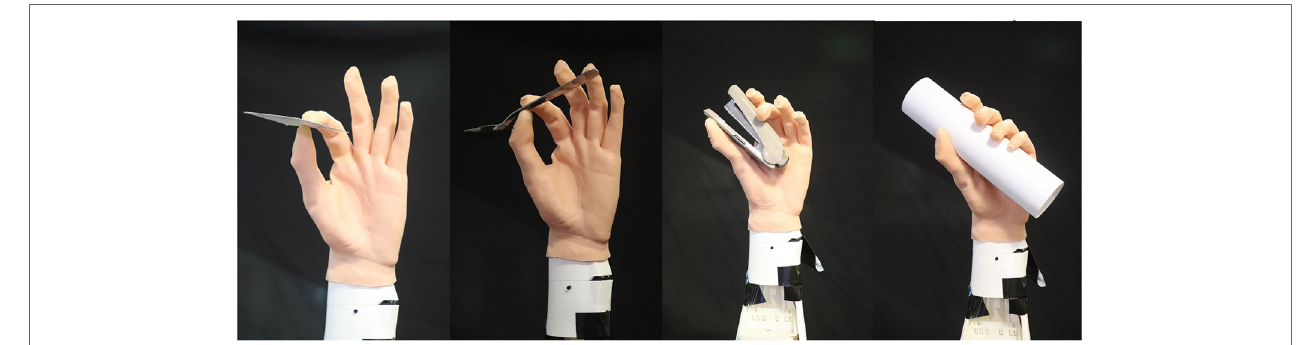
FigUre 10 | Grasping experiment with artificial